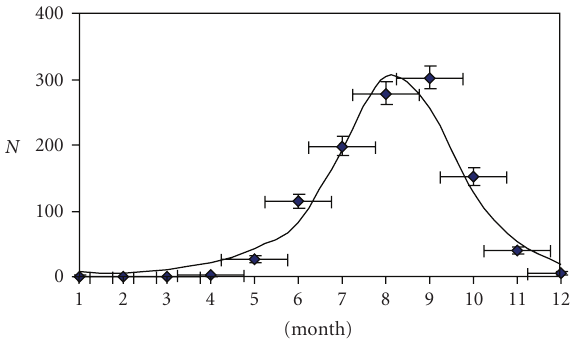
Figure 3: Number of storms predicted per month of the year during the period 1960–2007 versus numbers actually observed for the combined Atlantic and Eastern Pacific basins. The model predictions (continuous curve) have been smoothed and have been normalized to the data.